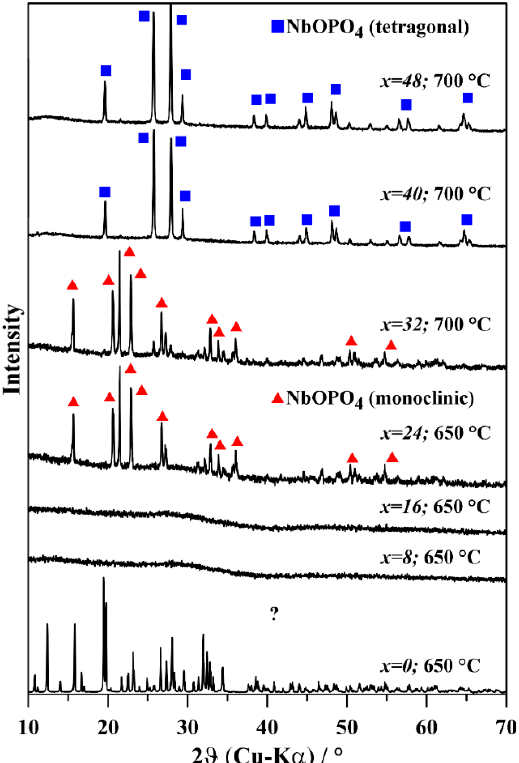
Figure 7. XRD patterns of crystallized samples of the (100 − x)[0.4Na 2 O-0.2Nb 2 O 5 -0.4P 2 O 5 ]-xB 2 O 3 glasses.